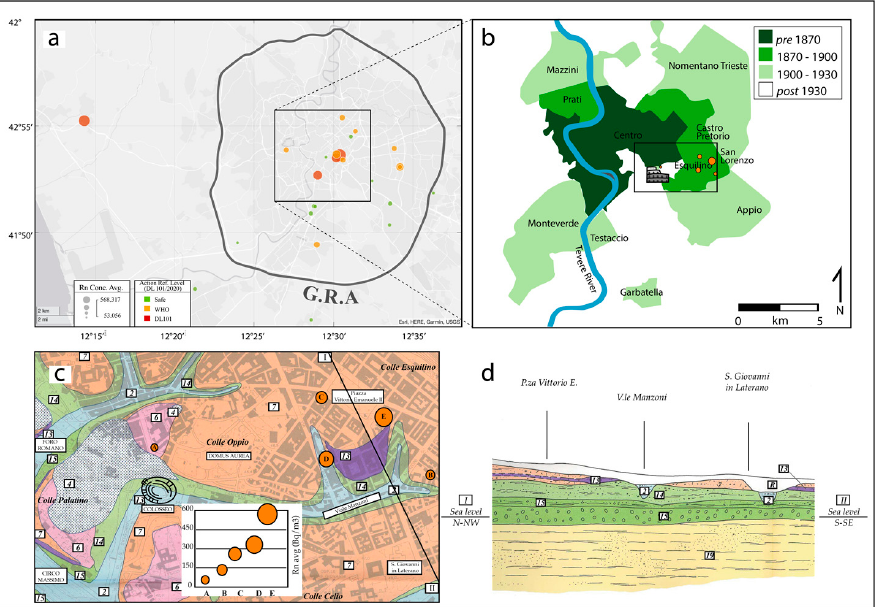
Figure 6. ( a ) Map of average radon concentration (Bq/m 3 ) recorded in the 25 apartments of Experi- ment 1. The size of the bubbles scales with average radon concentration (Rn Avg). Colors represent the category of risk to health: green stands for SAFE values (RnAvg < 100 Bq/m 3 ), orange stands for values under WHO threshold (RnAvg < 300 Bq/m 3 ), red stands for values over EURATOM threshold (RnAvg > 300 Bq/m 3 ). ( b ) Urban development in an area of the city of Rome corresponding to the square inset of Figure 6a; colors indicate the age of buildings (modified from [37]). ( c ) Location of the apartments (orange circles) of the historic center on the geologic map of Rome (modified from [38]). Legend of the geologic units: R Riporti (Anthropogenic deposits); 2 Recent alluviumi; 4 Fluvio lacus- trine deposits; 6 Tufo Lionato; 7 Pyroclastic fall; 13 Tufo del Palatino; 14 Paleotiber b; 15 Paleotiber a; 19 Mt Vaticano. Bubbles labeled A, B, C, D, and E refer respectively to apartments FrancescoB, SergioD, GeaC, MartaR, LorenzoC. ( d ) I-II Trace of section; section Scale: Lengths 1:10,000, Heights 1:2000 (modified from